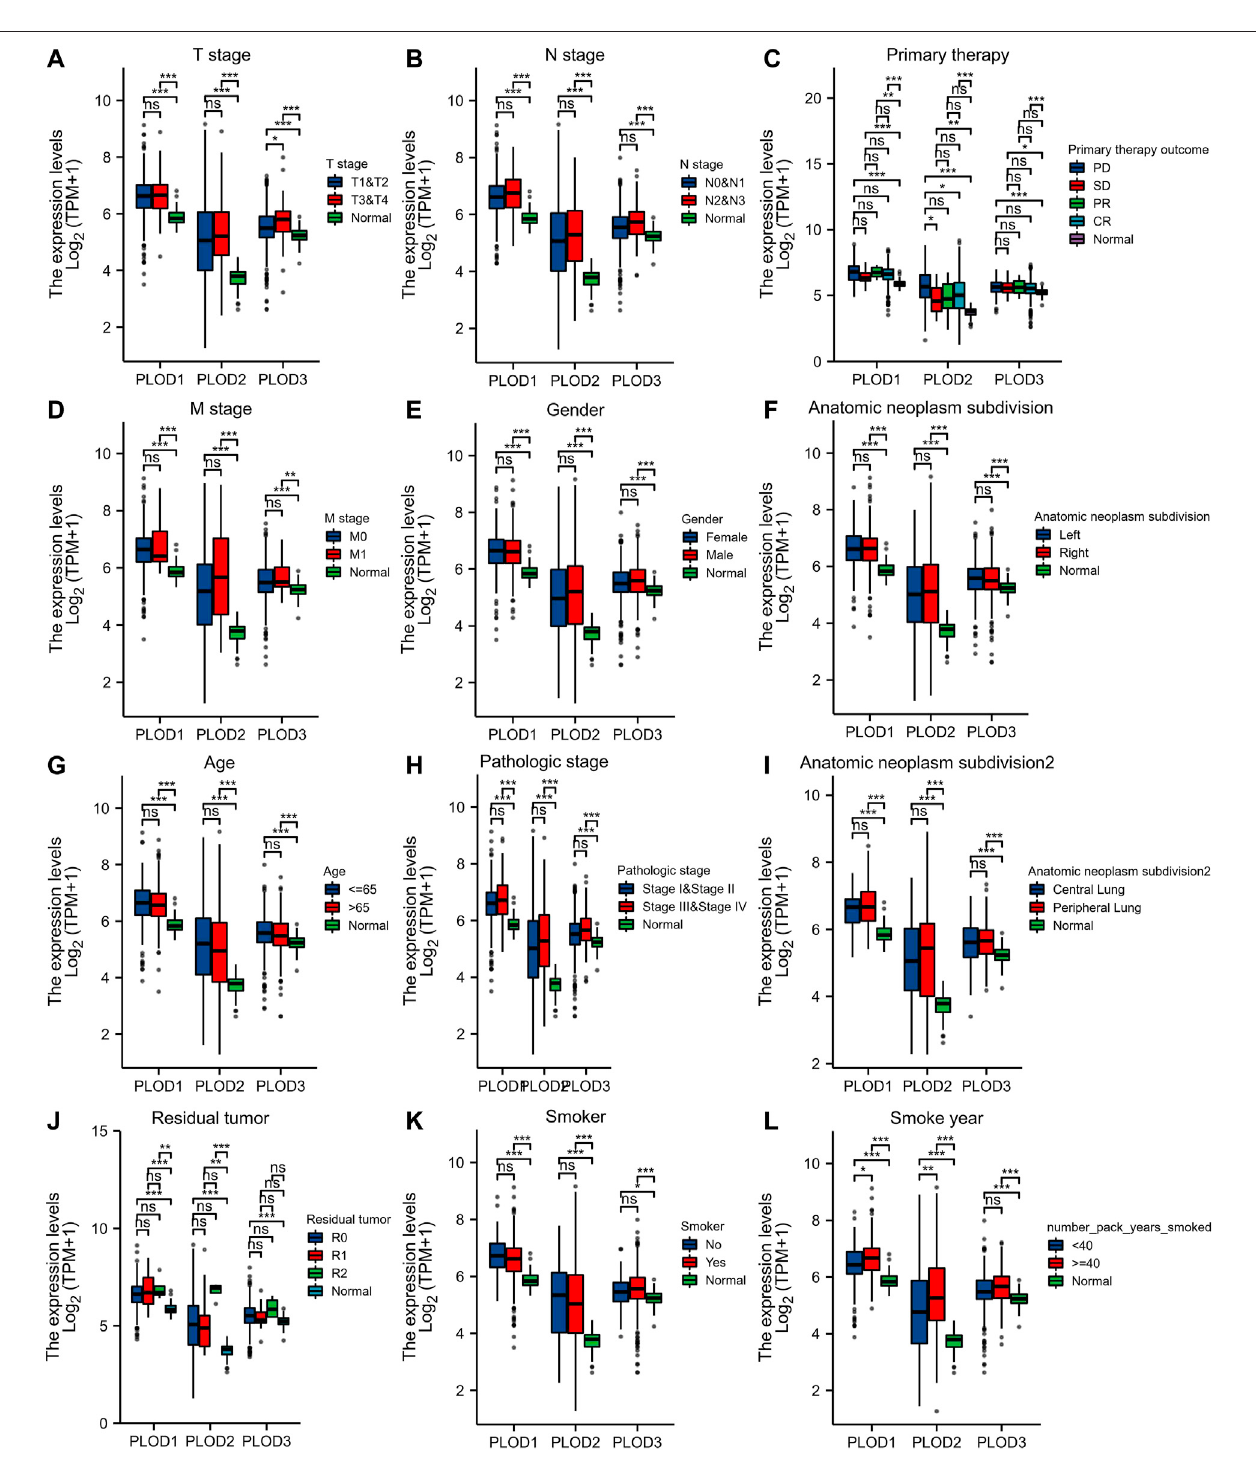
FIGURE 4 | Evaluate relationship between mRNA expression level and various clinicopathological characteristics. The association of mRNA with clinical pathological characteristics including T stage (A) , lymph node metastases (B) , primary therapy outcome (C) , M stage (D) , sex (E) , anatomic neoplasm subdivision (F) , age (G) , pathologic stage (H) , anatomic neoplasm subdivision 2 (I) , residual tumor (J) , smoker (K) , and smoking status (L) are demonstrated in this plot. ns, no signi fi cance, * p < 0.05, ** p < 0.01, *** p < 0.001.